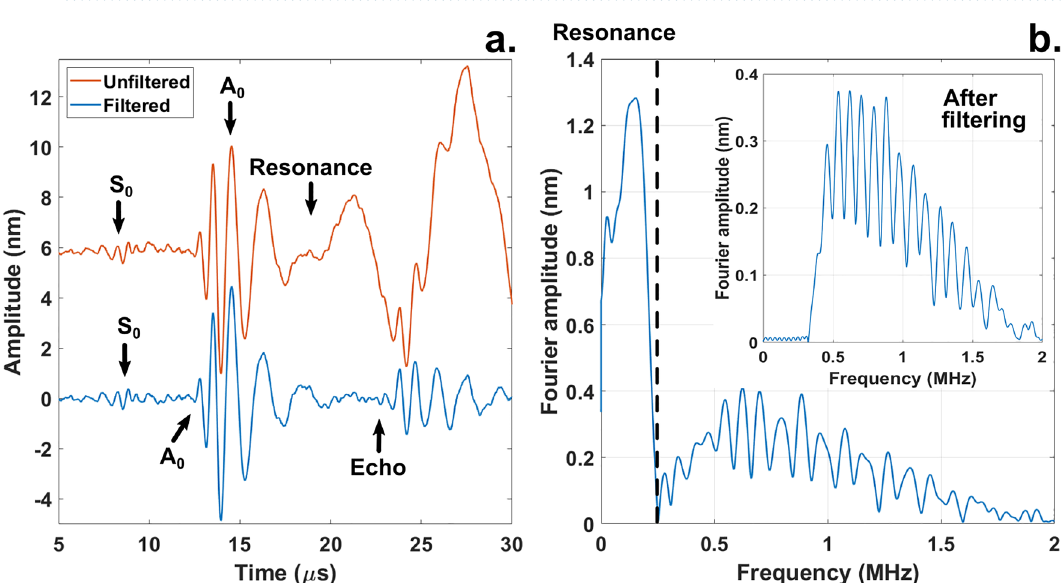
Figure 2. Filtering to remove standing waves in the structure. Signal shape produced by a point excitation on a damaged sample ( a ) and its frequency content ( b ). The raw signal (a, red, offset 6 nm for clarity) features a resonance that masks the echo. A high pass Fourier filter ranging from 0.1 to 0.5 MHz ( b ) removes the standing wave interference and reveals an echo (a,